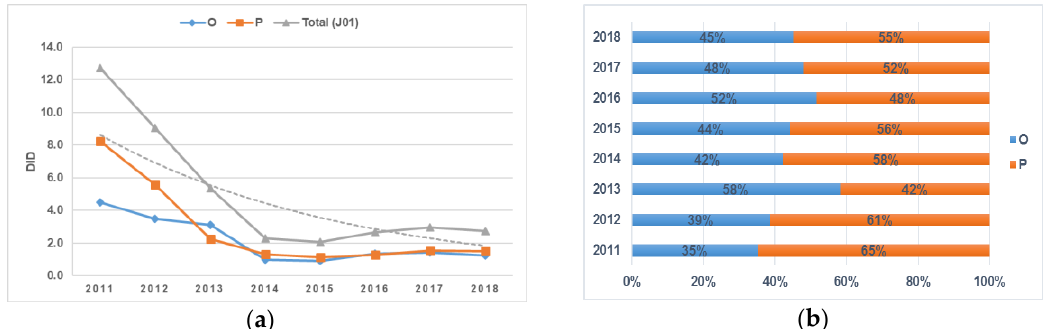
Figure 1. ( a ) Dynamics of changes in antimicrobial consumption according to the route of administration (oral: O; parenteral: P) in Kazakhstan in the period 2011–2018; ( b ) dynamics of changes in the proportion (%) of antimicrobial consumption according to the route of administration (oral: O; parenteral: P) in Kazakhstan in the period from 2011 to 2018.